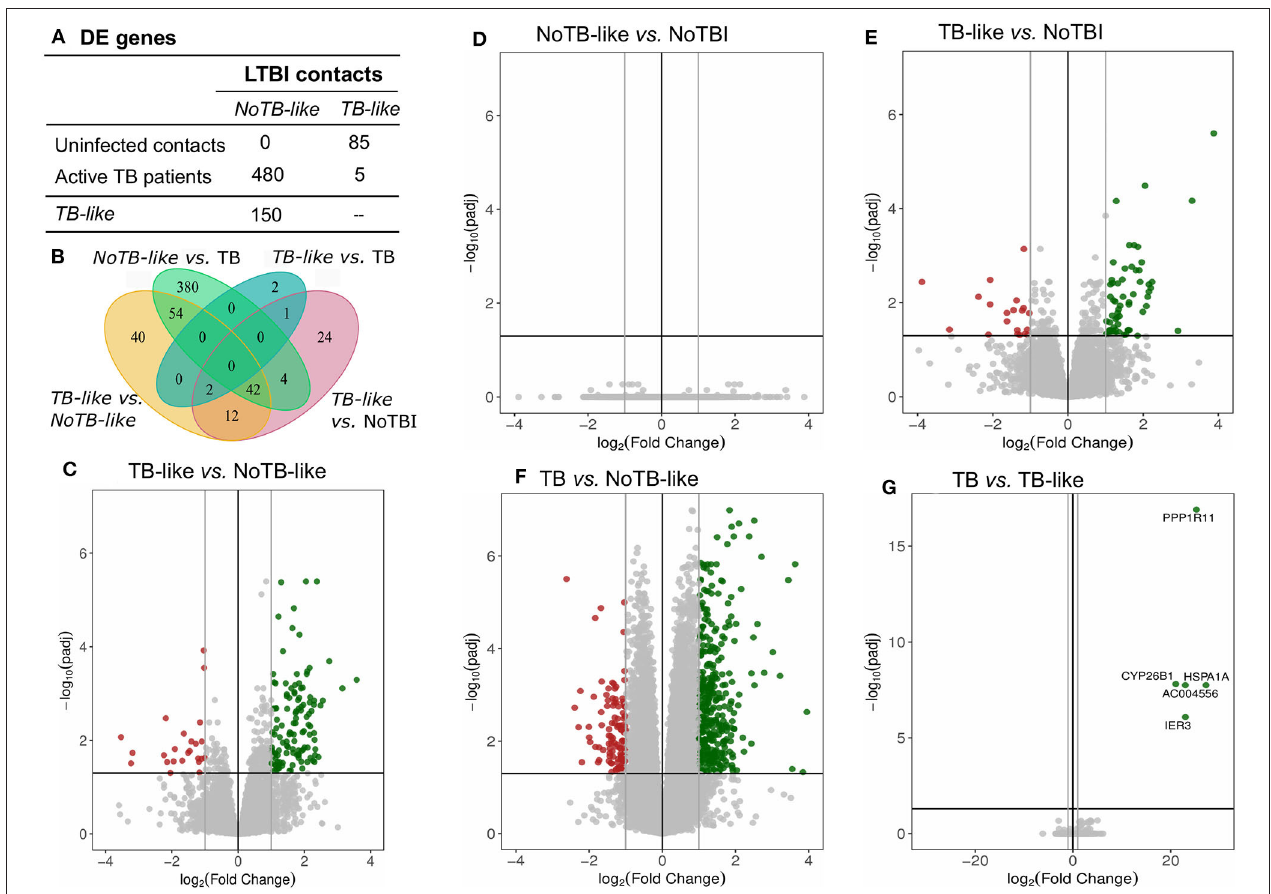
FIGURE 5 | Genes differentially expressed in LTBI subgroups compared between them and to NoTBI and active TB patients. (A) Table summarizing the number of DE genes on each pair-wise comparison (columns vs. rows). (B) Venn diagram showing the overlapping genes between signatures. (D–G) Volcano plots highlighting the genes with significant (adjusted p < 0.05) fold Change between groups. Up-regulated genes (Log2(Fold Change) > 1) in green and down-regulated genes (Log2(Fold Change) < -1) in red. The differential expression analysis was made using the DESeq2 R package, comparing all annotations of the reference genome (34947 annotations). Genes PPP1R11 and AC004556, which showed a log2(Fold Change) < -20, are not represented in the volcano plot (C)